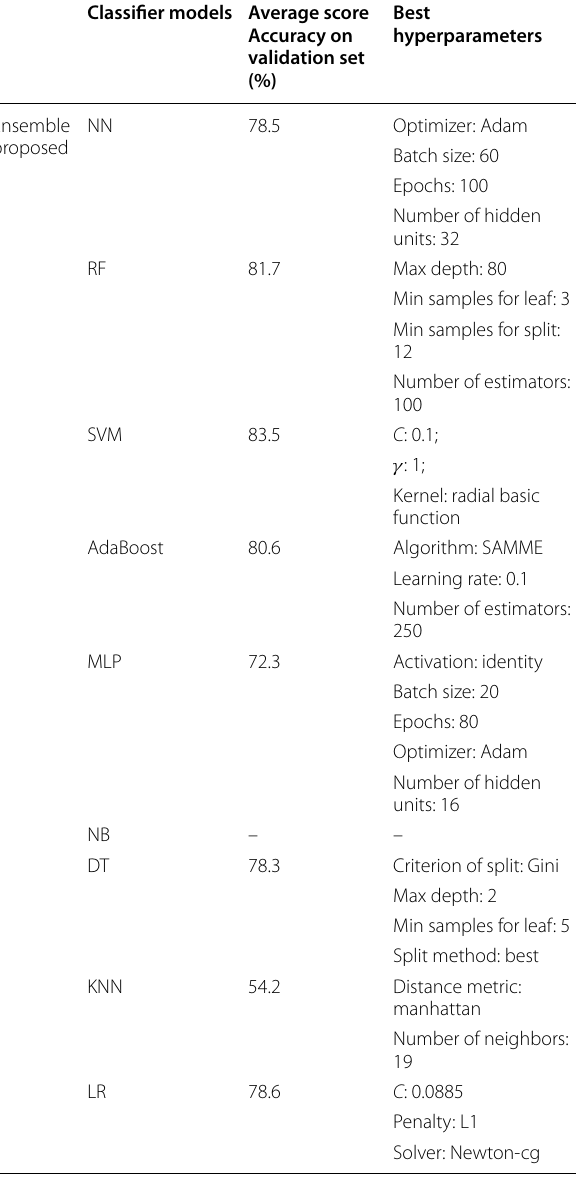
Table 6 Reports for each method the average score obtained during Grid Search and values of hyperparameters most frequently selected during k -fold nested-cross-validation Classifier models Average score Accuracy